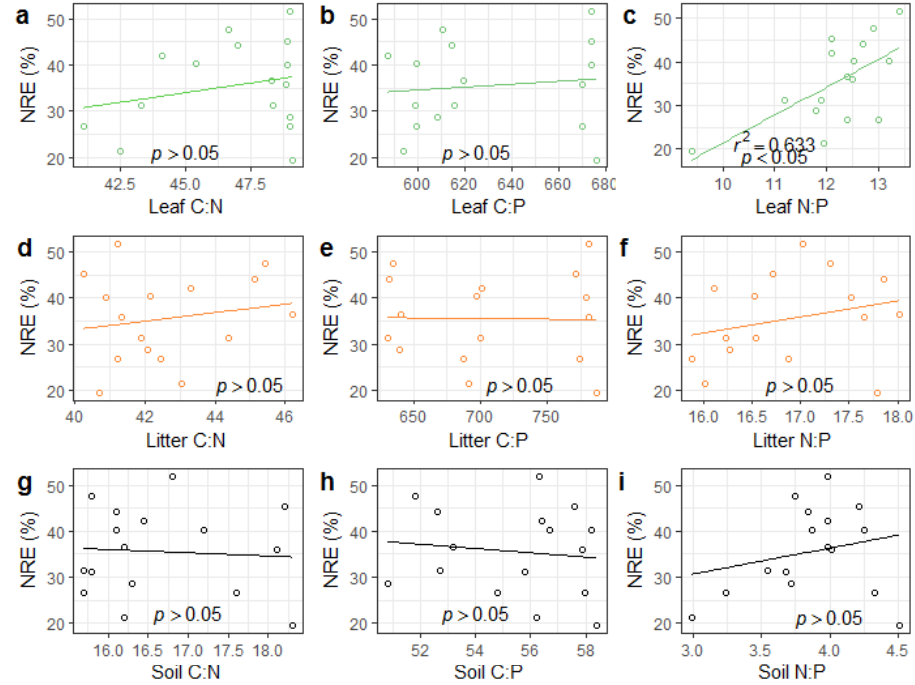
Figure A2. Relationships between NRE (N resorption efficiency) and leaf ( a – c ), litter ( d – f ), and soil ( g – i ) stoichiometry.